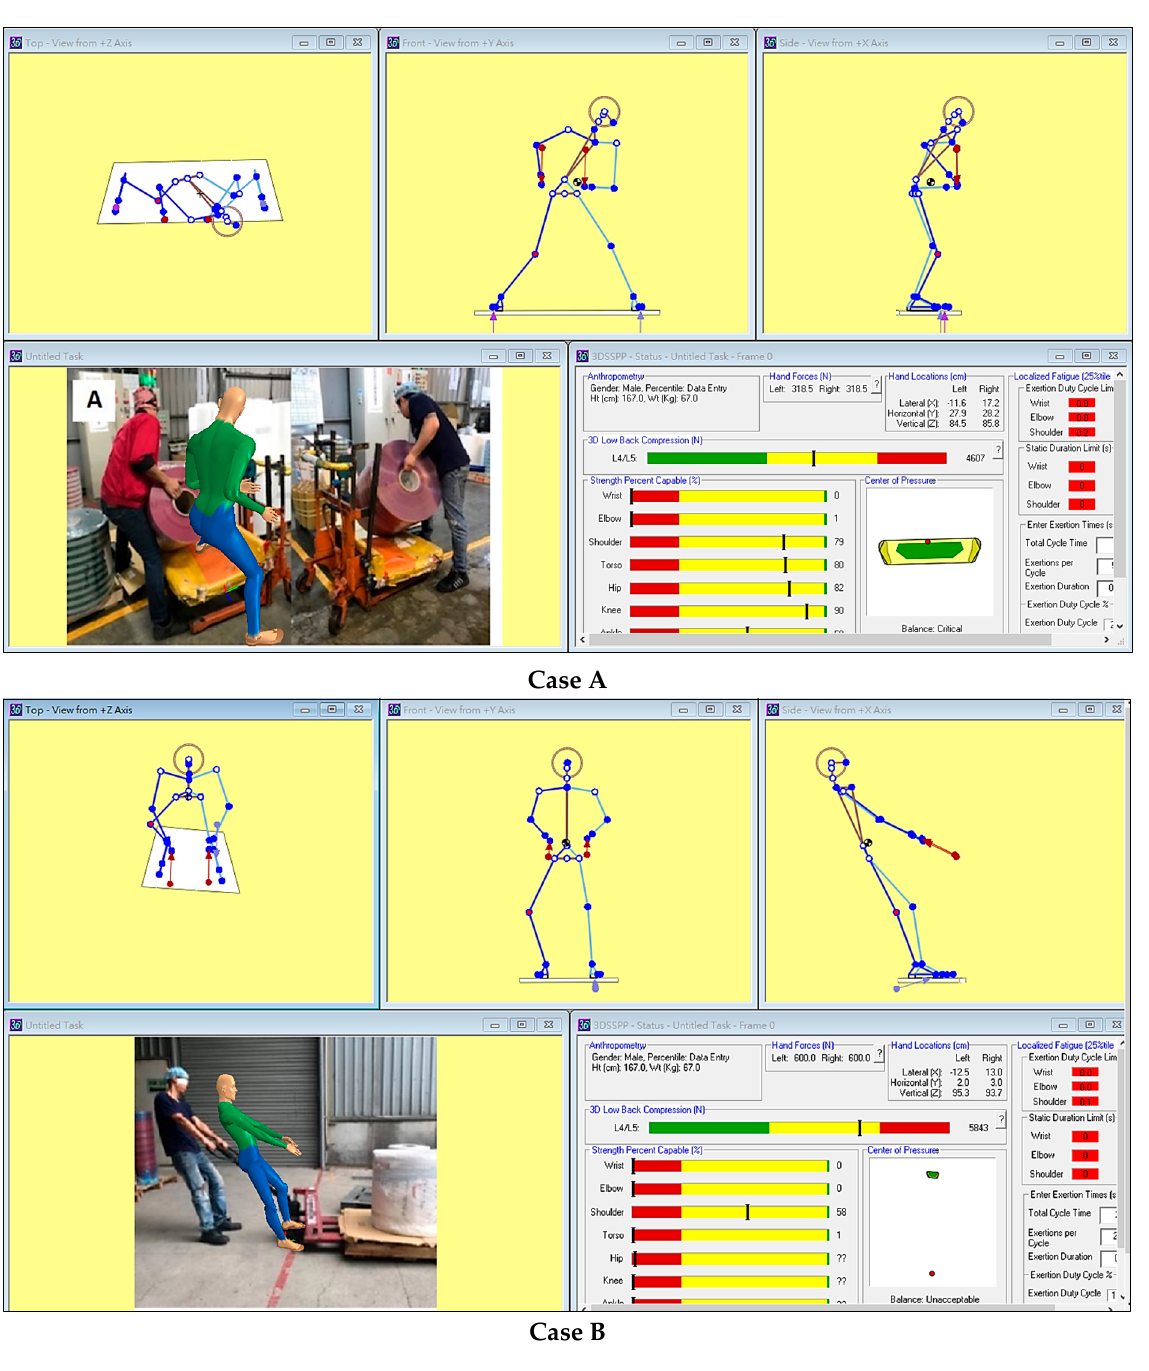
Figure 2. Loads on the lower back in Cases A and B, as determined using the 3D Static Strength Prediction Program.